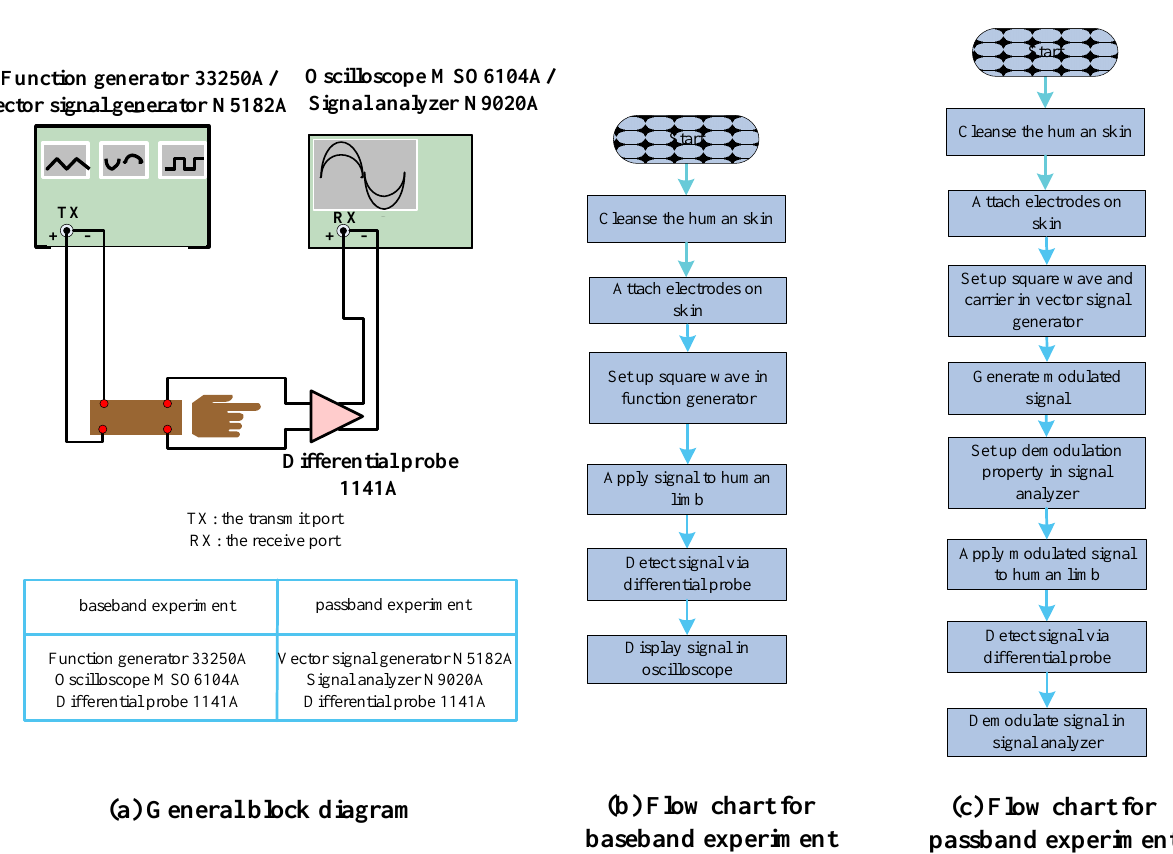
Figure 5. IBC channel baseband and passband transmission experiment set-ups: ( a ) General block diagram; ( b ) Flow chart for baseband transmission experiment; and ( c ) Flow chart for passband transmission